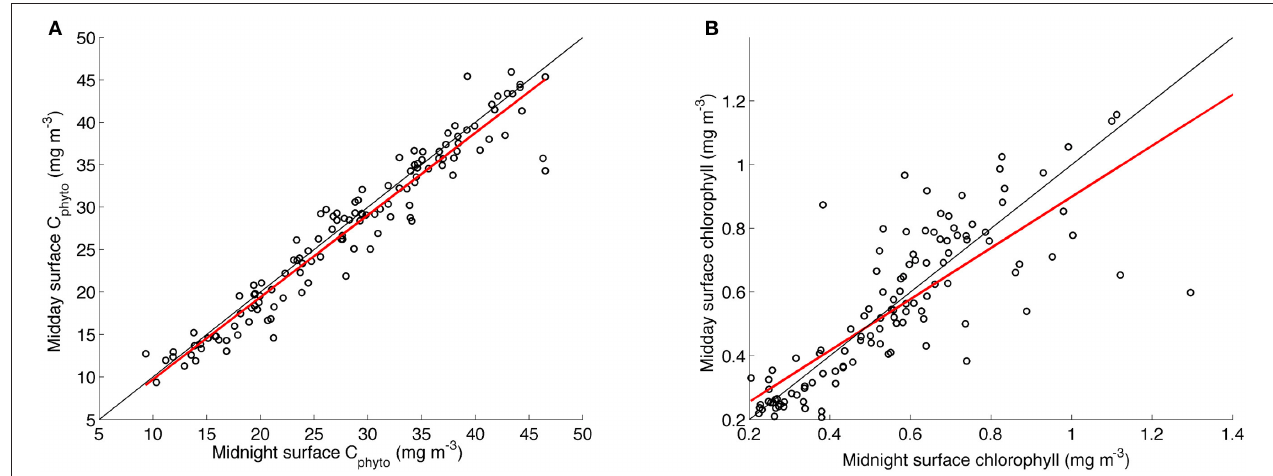
FIGURE 7 | Linear regressions of daily surface midnight vs. daily surface midday concentrations of (A) C phyto from the glider transect using the B05 method (slope = 0.97, r 2 = 0.93, rmse = 2.49) and (B) chlorophyll (slope = 0.8, r 2 = 0.66, rmse = 0.15). The linear least square regression line appears in red with the one to one line in black.